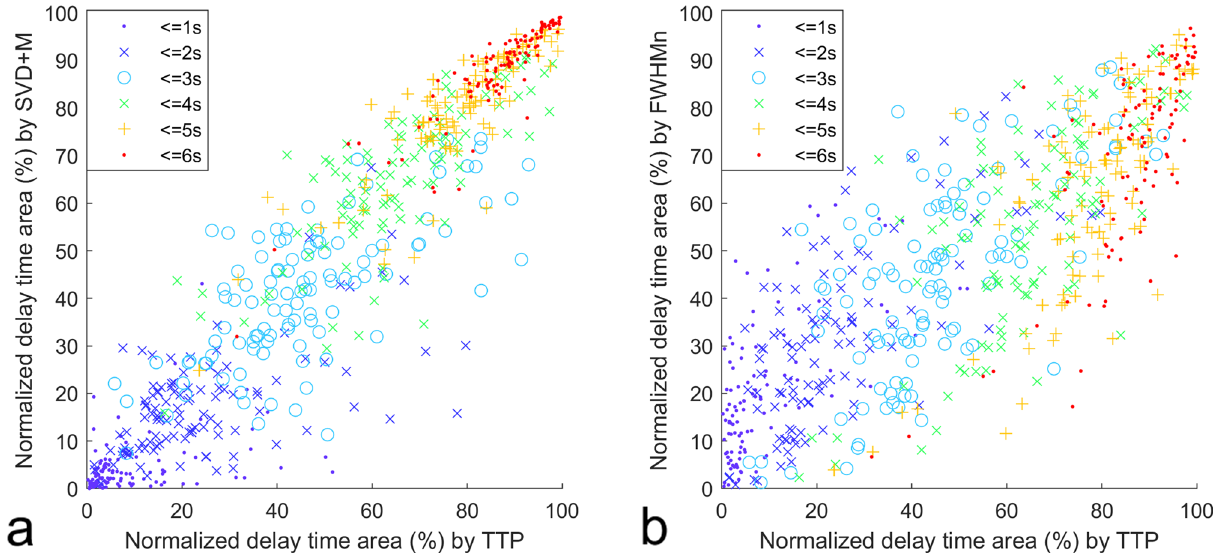
Figure 6. Scatterplots of normalized delay time areas at thresholds of 1, 2, 3, 4, 5, and 6 s (color-coded accordingly) with TTP as × coordinate and ( a ) Tmax estimated by SVD +M , ( b ) FWHM n as y